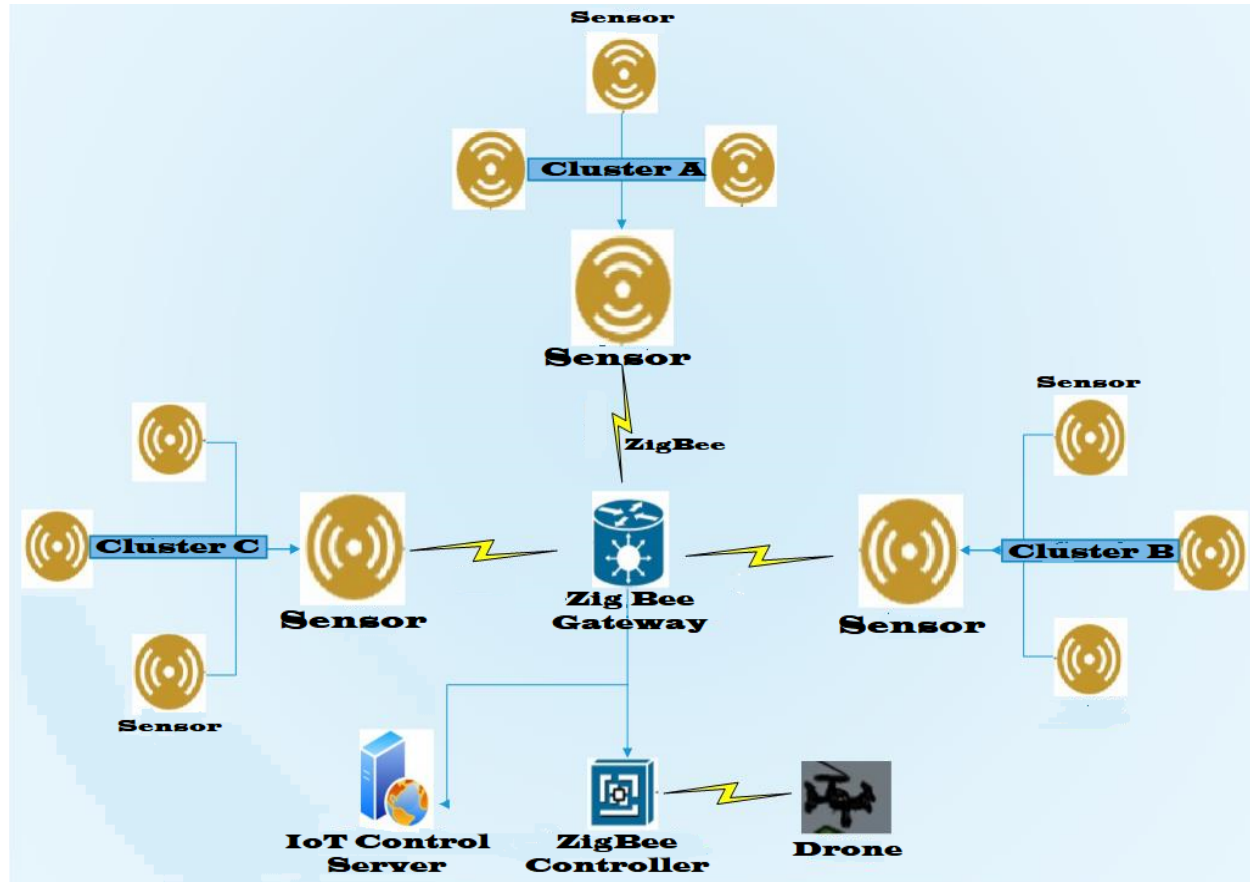
Figure 6. Detection-Response system flow diagram.